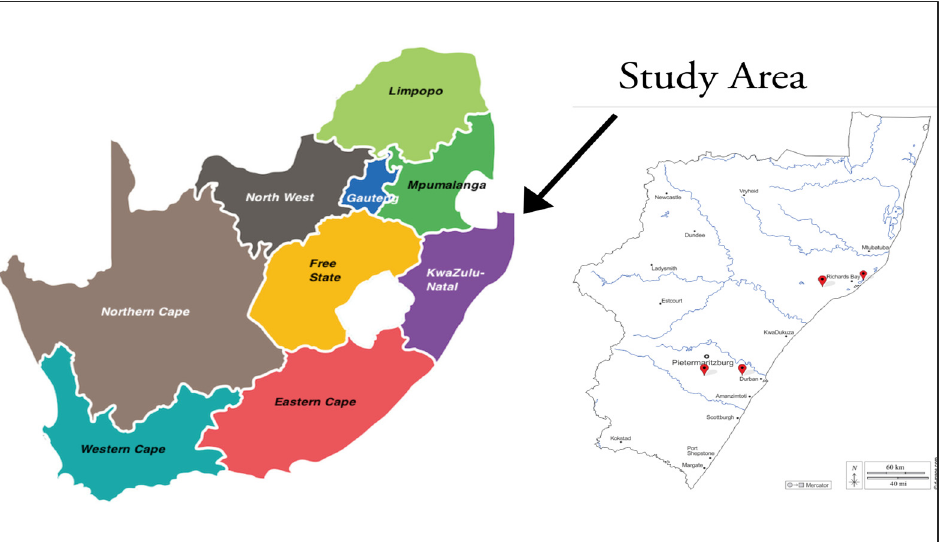
Figure 1. Map of South Africa showing the location of KwaZulu-Natal province .